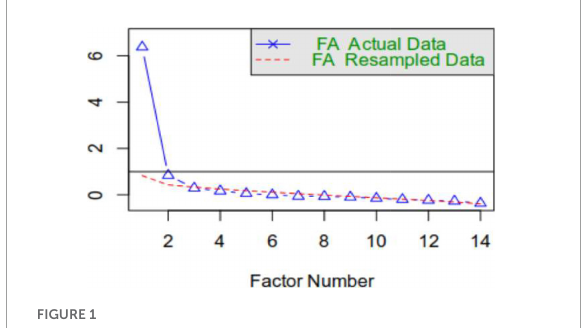
FIGURE1 Scree plot of the parallel